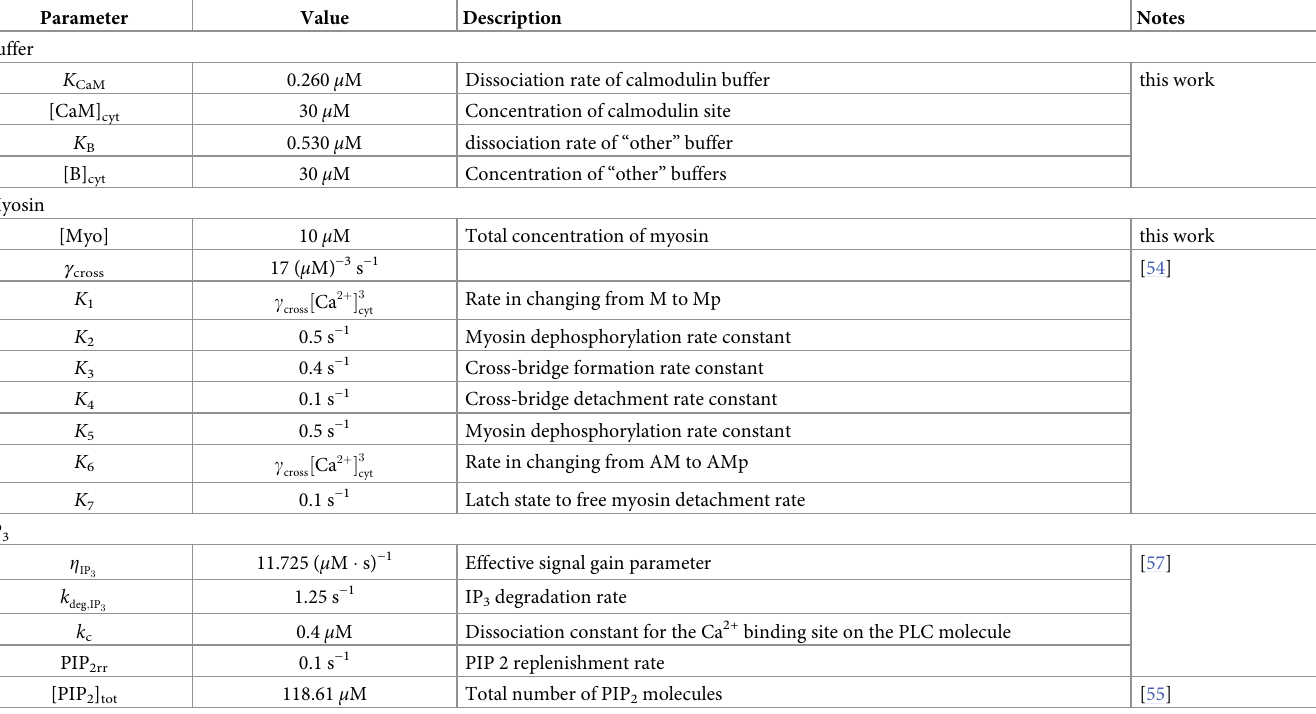
Table 1. Cytosol-specific model parameters. Buffer parameters rescaled from [55] to yield a baseline buffering ratio of 1%, consistent with [56]. [Myo] made small to have little impact relative to other buffers. Parameter Value